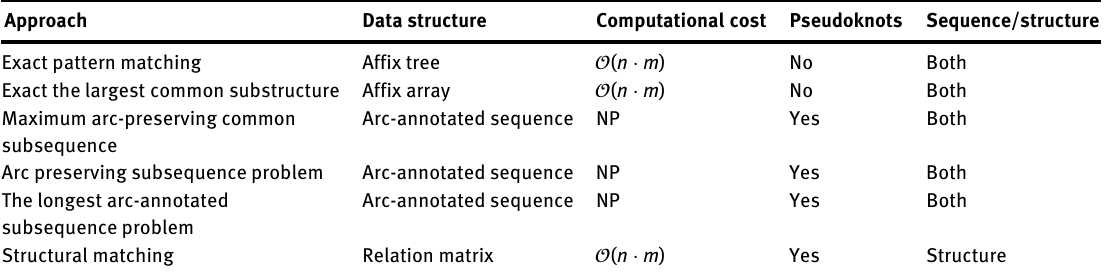
Table 4: Comparison of the method (structural matching) with other proposed approaches to extract the RNA substructures.